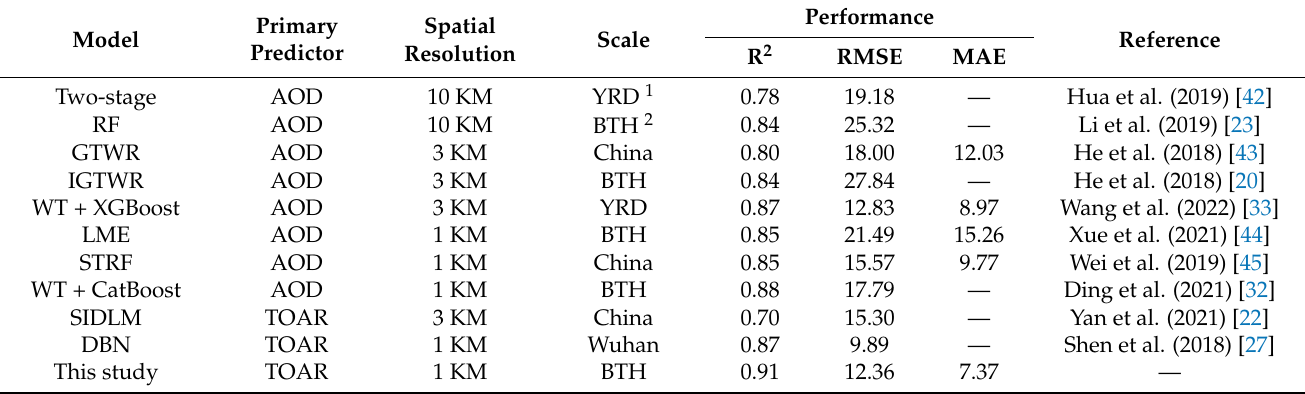
Table 6. Comparison of the performance of different models for PM 2.5 daily concentration estimation based on MODIS